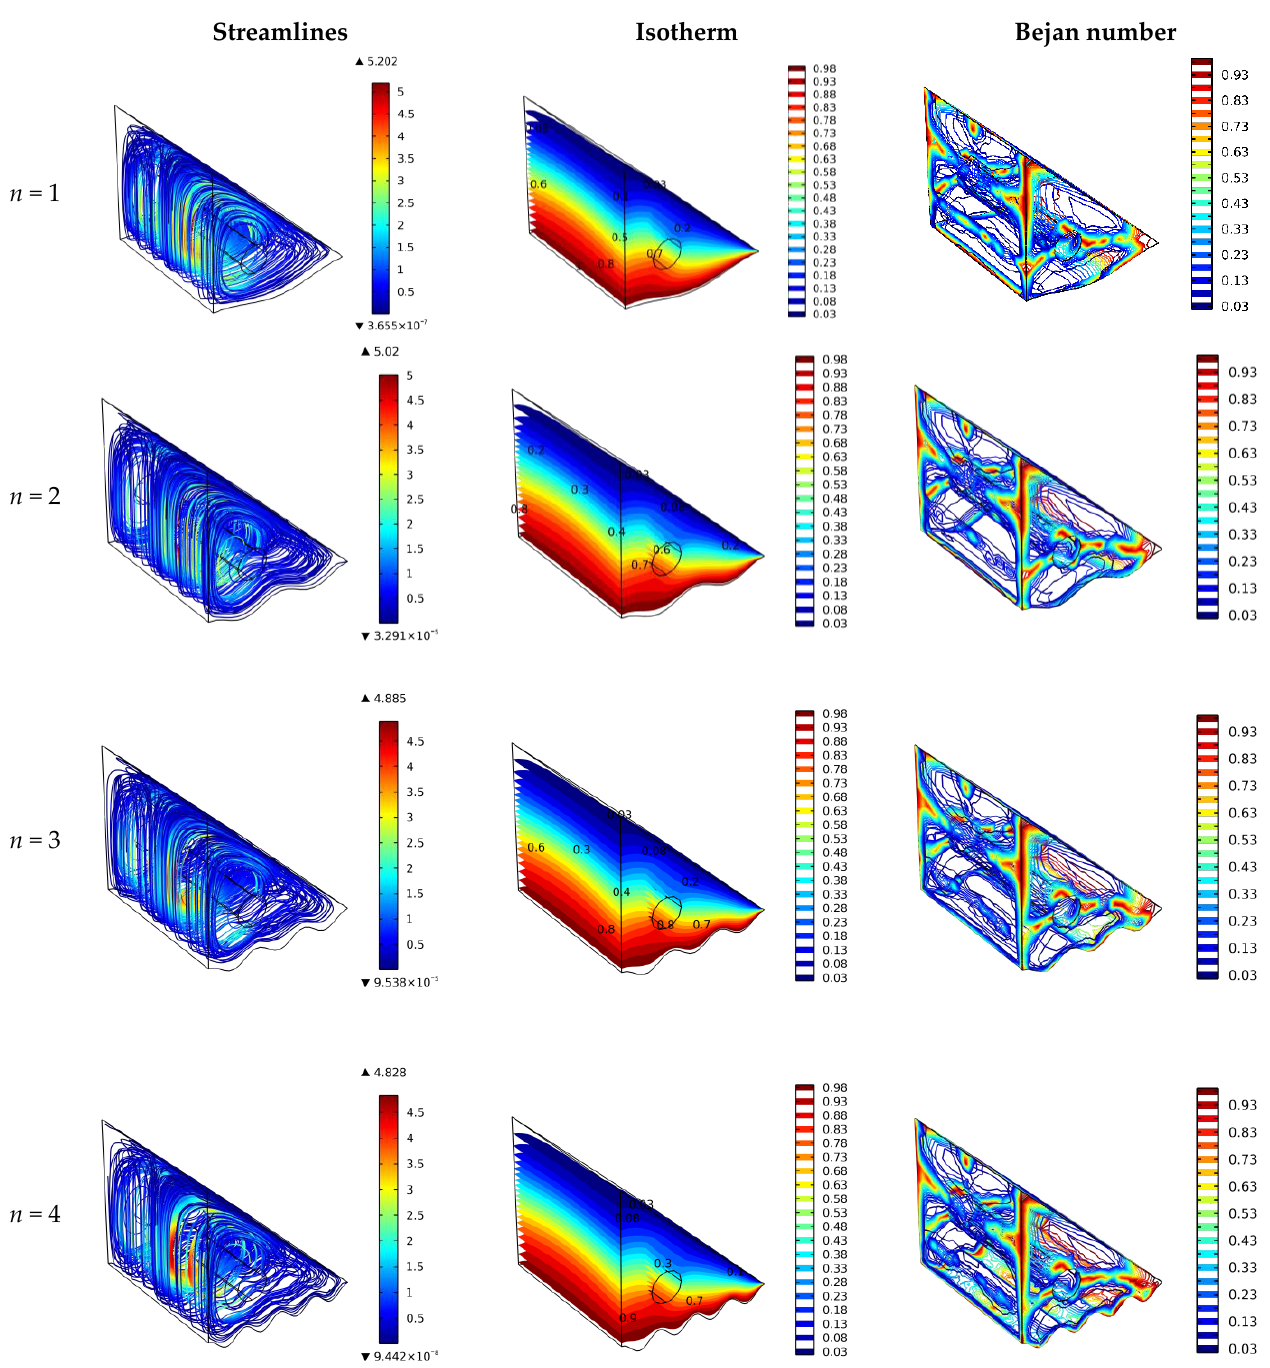
Figure 5. Surface plots of the velocity, temperature, and Bejan number for various wall undulation numbers.